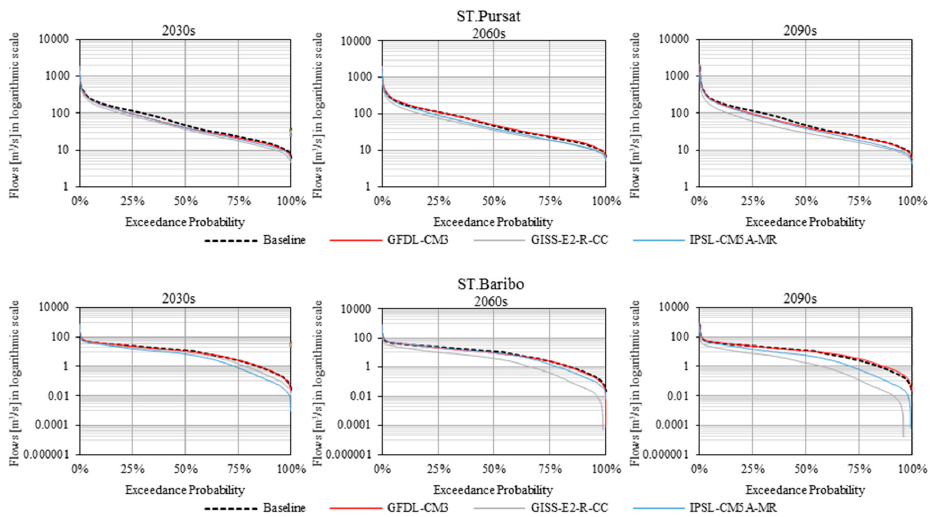
Figure 4. Flow duration curves of the baseline and for each GCM for three time horizons (2030s, 2060s, and 2090s).